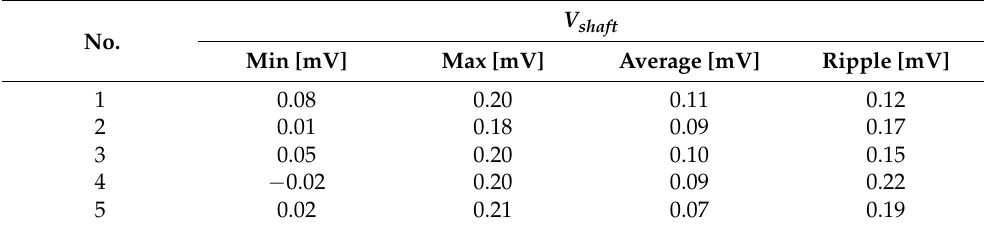
Table 3. Third test result using a potential sensing voltage of 0.001 mV and an input/output stage smoothing